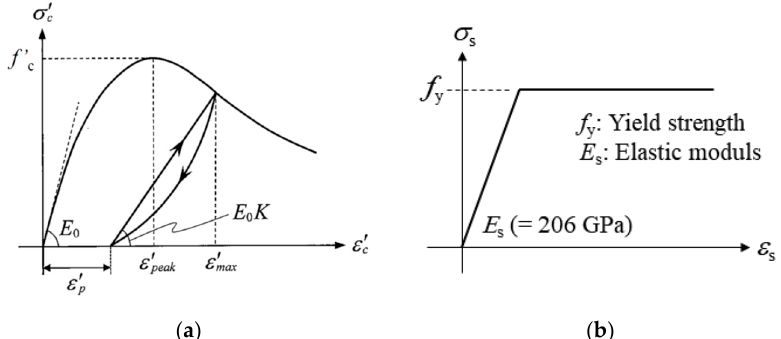
Figure 4. Stress-strain relationships of concrete and rebar for fiber model calculation, ( a ) Concrete, ( b ) Steel rebar.